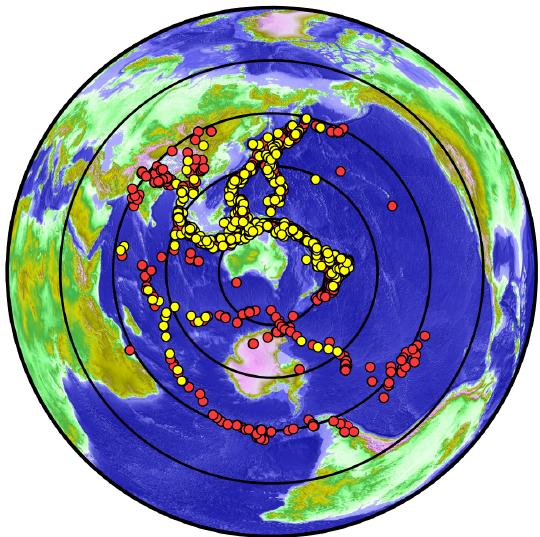
Figure 3. Distribution of distant earthquakes (teleseisms) used in this study. The locations of events that are ultimately used for RF analysis are denoted by yellow dots. Concentric circles are plot- ted at 30 ◦ intervals from the centre of Bass Strait. Topography and bathymetry colours are based on the ETOPO1 dataset (Amante and Eakins,